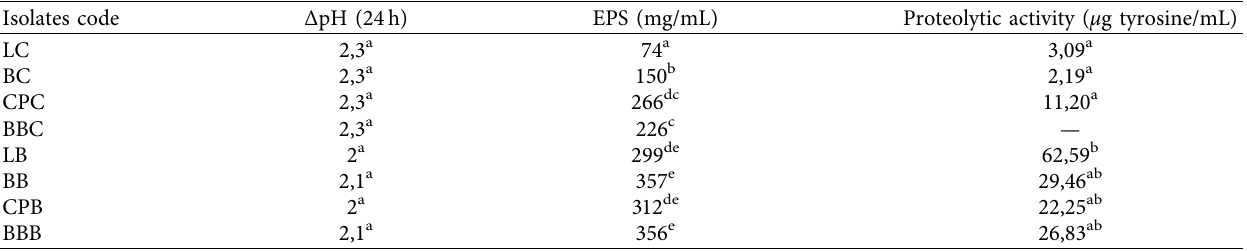
Table 3: Properties of LAB.